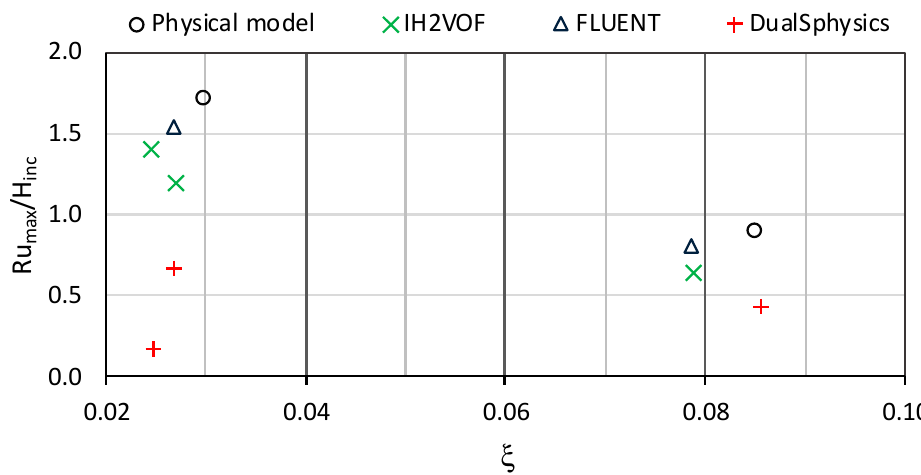
Figure 15. Maximum wave run-up as function of Iribarren number, ξ , for cases 1, 3, and 4.